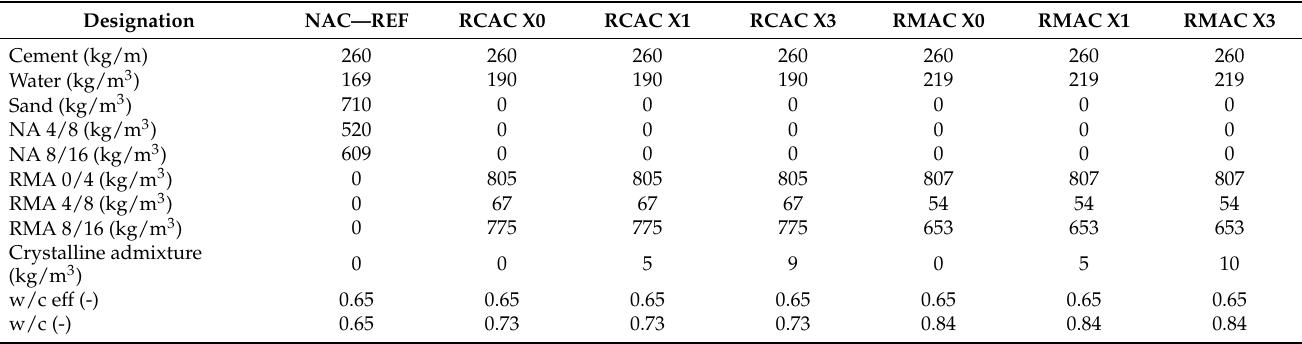
Table 2. Concrete mix proportion, per cubic meter.